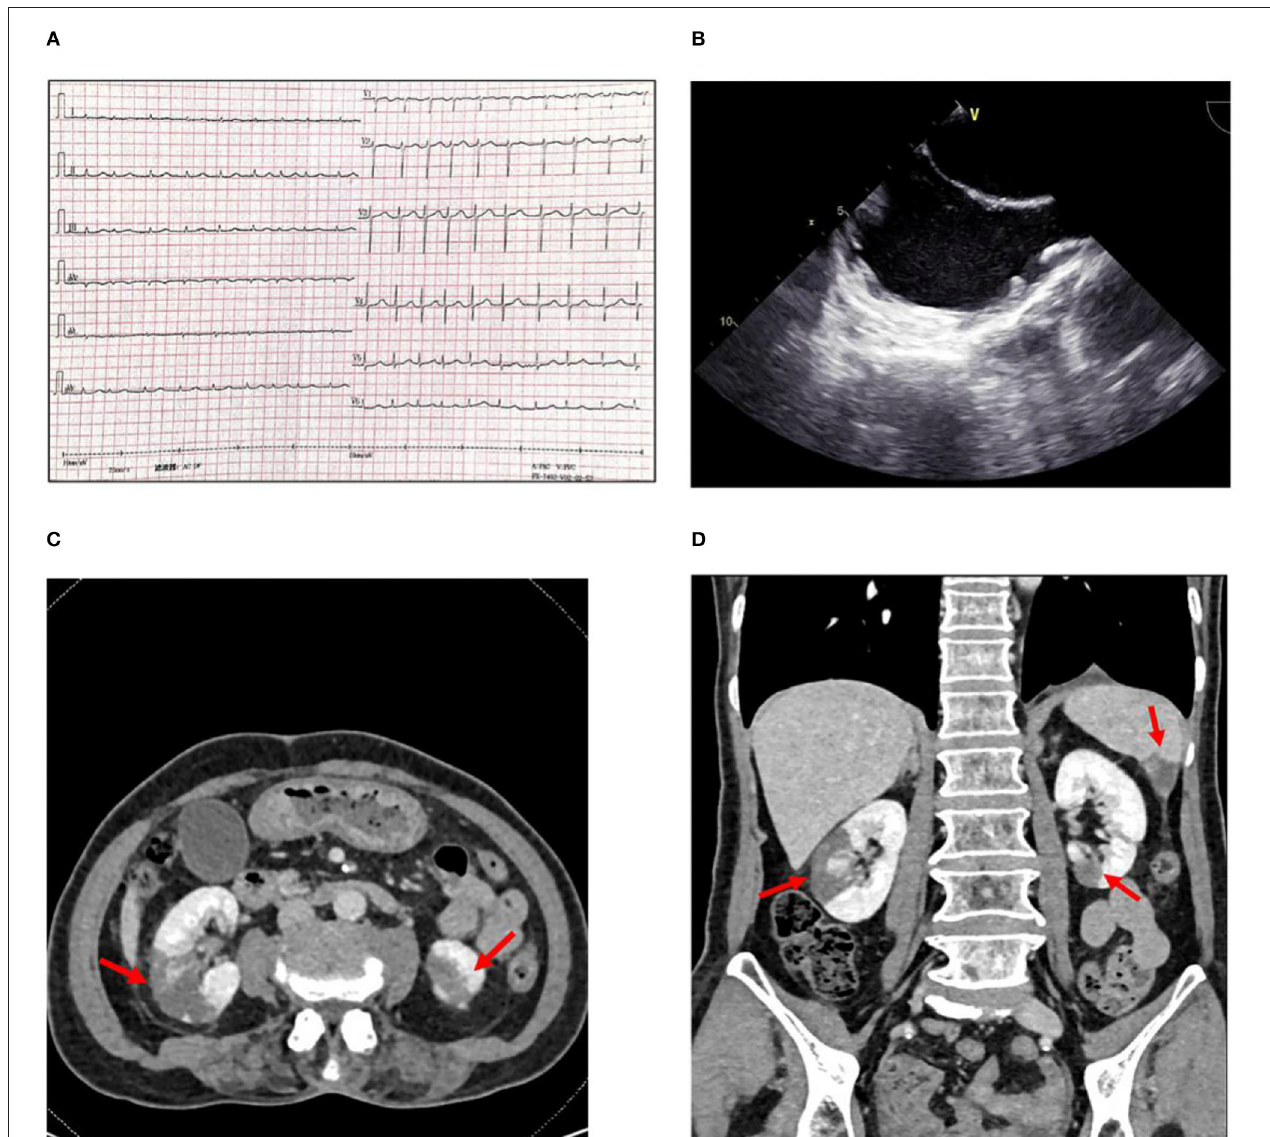
FIGURE 1 | (A) Electrocardiogram showing atrial fibrillation with a rapid rate. (B) Transesophageal echocardiography showing spontaneous echo contrast (SEC) in left atrium and atrial appendage. (C) Abdominal CT scan with intravenous contrast shows infarctions (arrows) in the middle right and (D) Inferior left renal parenchyma and the inferior aspect of the